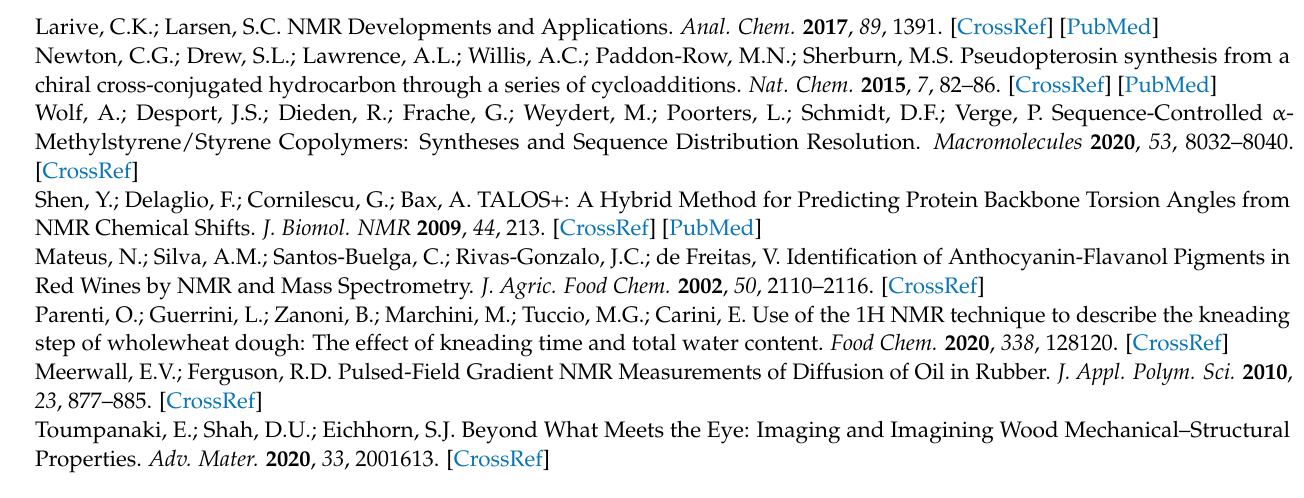
H NMR spectrum of AM. Supplementary S4, The 1 H NMR spectrum of MEA: Figure S3. The 1 H NMR spectrum of MEA. Supplementary S5, The 1 H NMR spectrum of PMAB gel: Figure S4. The 1H NMR spectrum of PMAB gel. Supplementary S6, The 13 C and DEPT-135 o NMR spectrum of gel: Figure S5. The 13 C and DEPT-135 o NMR spectra of PMAB gel. Supplementary S7, The NMR profile sperctra of pure PMAB gel without solvent: Figure S6. The NMR profile spectra of pure PMAB gel without